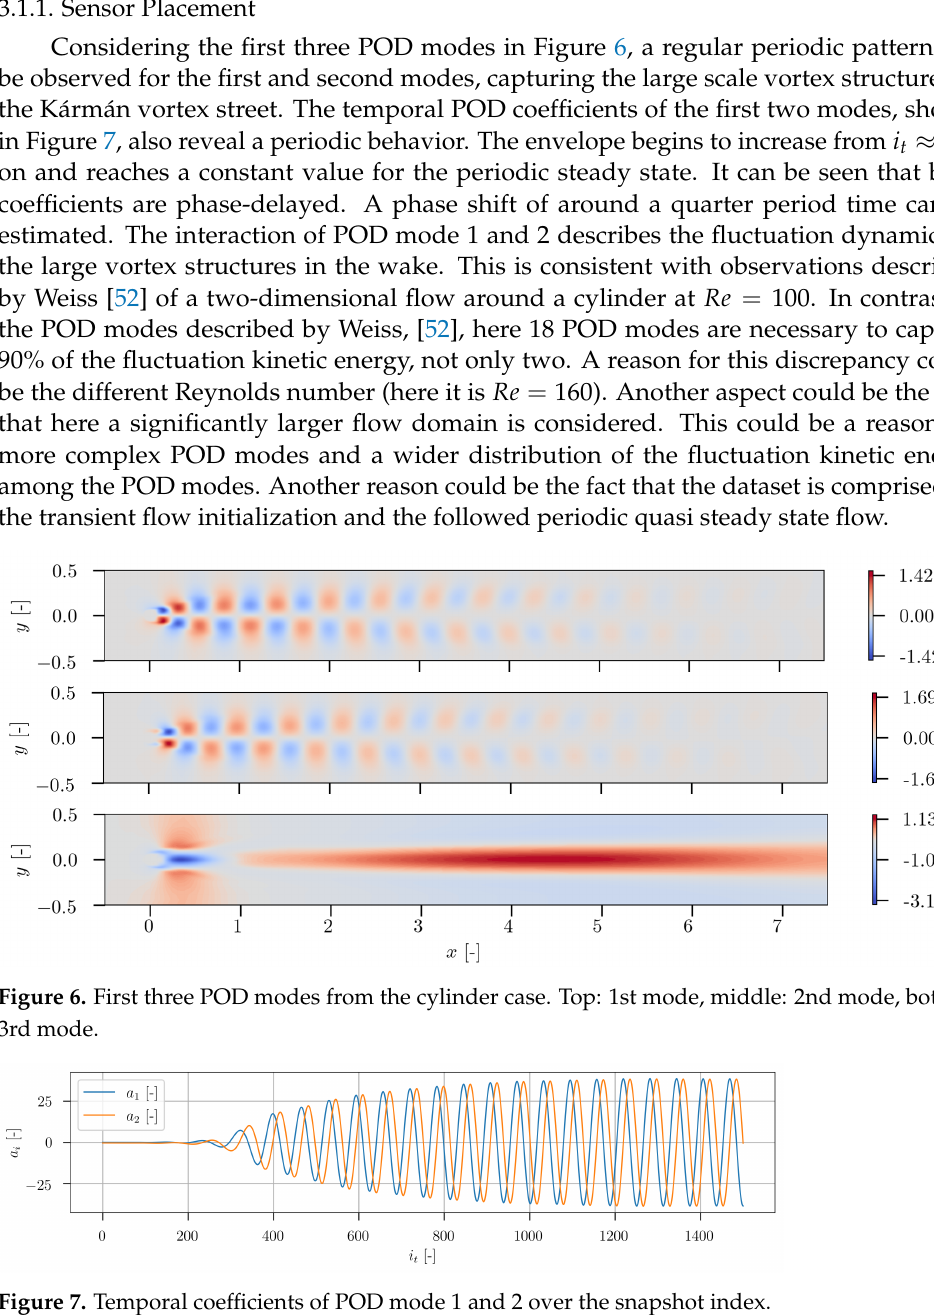
Figure 7. Temporal coefficients of POD mode 1 and 2 over the snapshot